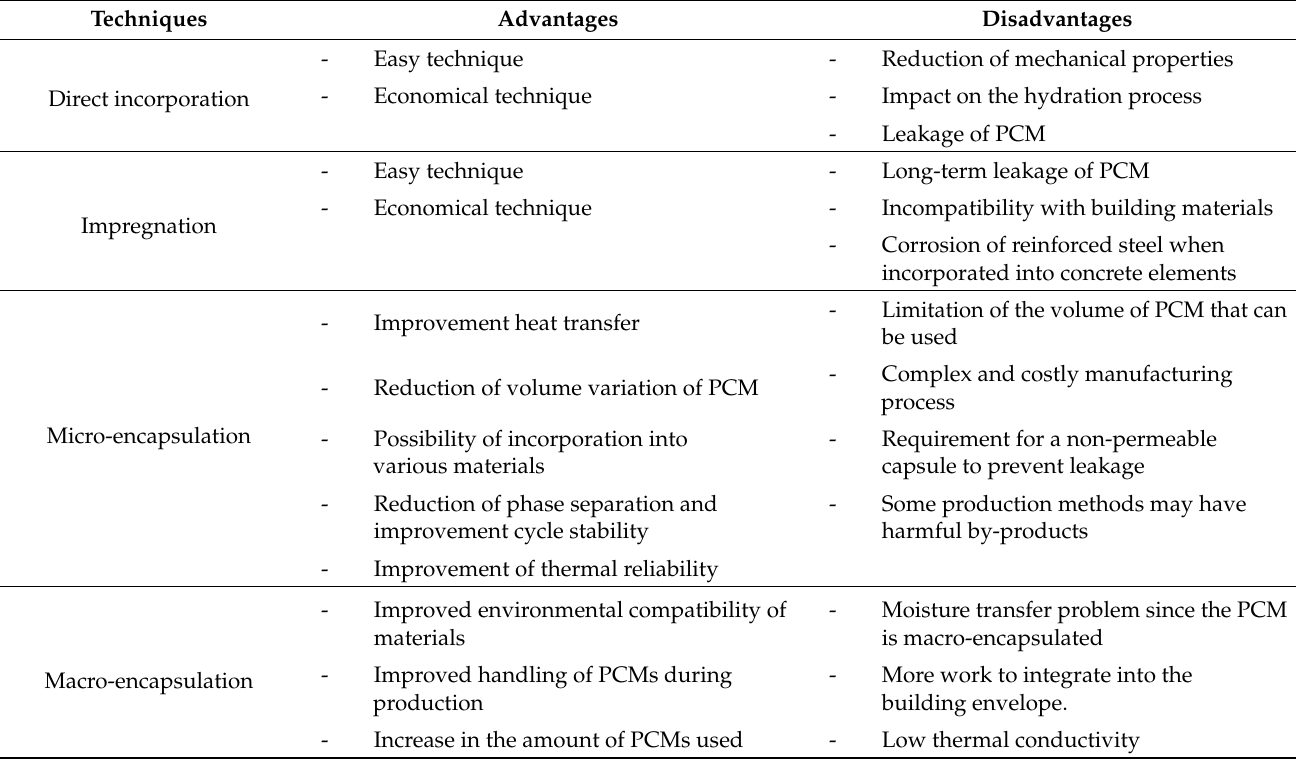
Table 3. Advantages and disadvantages of the different techniques for incorporating PCMs into buildings [9,18,47,49].